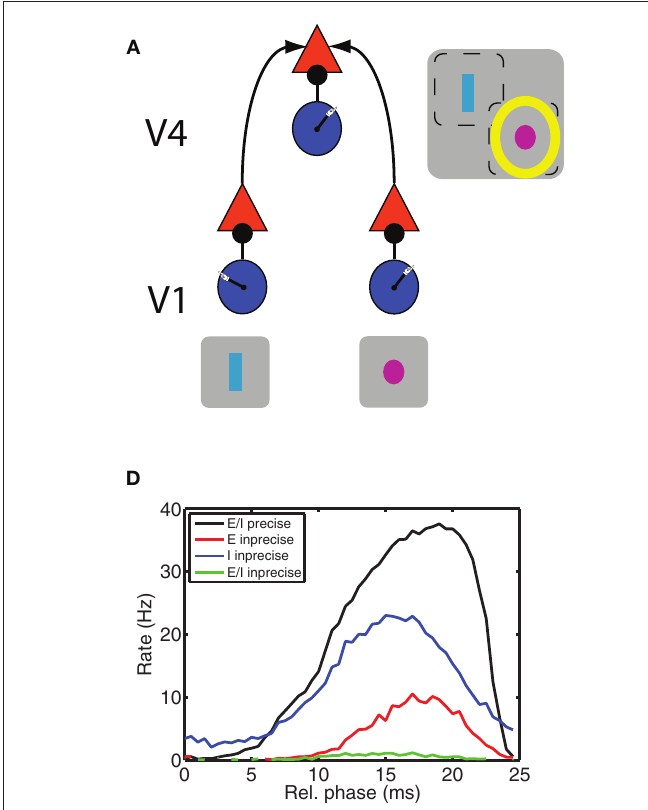
multiplied by a factor of five to illustrate the timing relationship more clearly) and (black) the membrane potential of the postsynaptic neuron receiving those synchronous synaptic drives. (D) The gating behavior is more clearly exposed by plotting the mean firing rate versus the delay between the E volley and I volley, here referred to as the relative phase. The firing rate is close to 0 when the E volley arrives just after the I volley and it is maximal when the E volley arrives just before. We show four different combinations of excitatory ( σ ) and inhibitory exc precisions ( σ ) expressed in terms of the standard deviation of spike times in the inh volley with units of ms: ( σ , σ ) is (black curve) (1,1), (red curve) (5,1), (blue exc inh curve) (1,5), and (green curve) (5,5). These curves show that relative phase operates most effectively as a gate when both inhibition and excitation